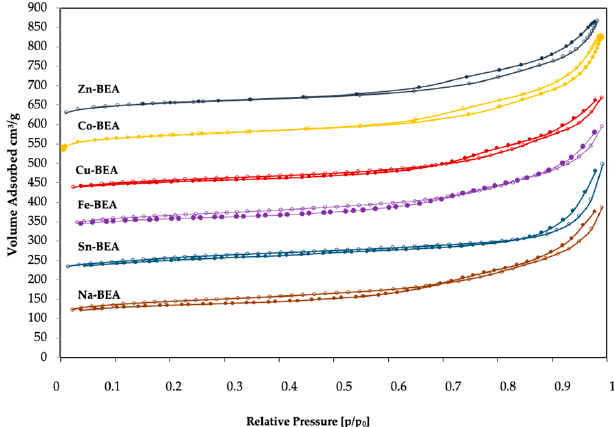
Figure 4. Nitrogen adsorption and desorption isotherms for synthetic BEA zeolites.